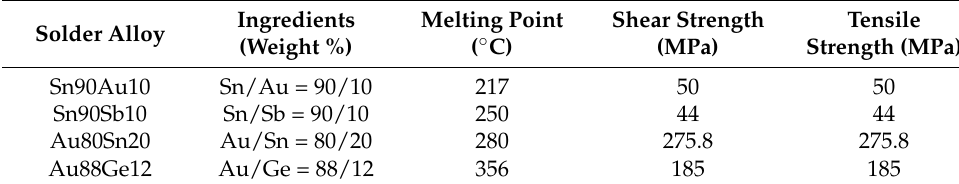
Table 1. Properties of different eutectic